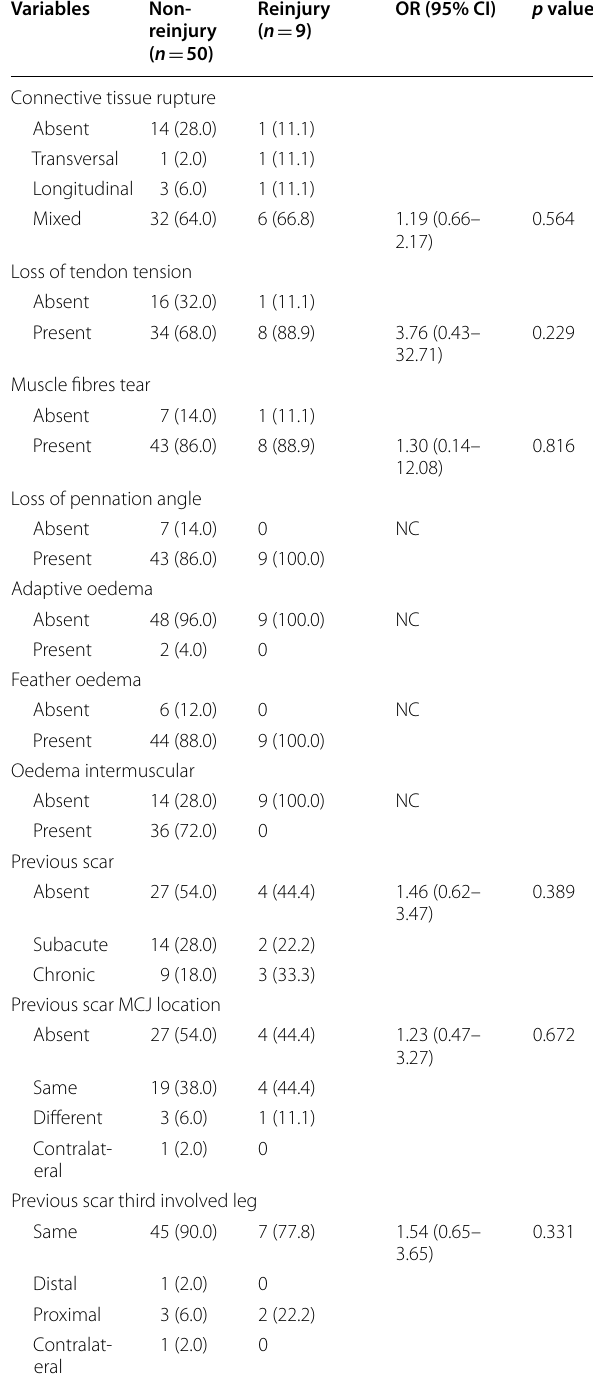
Table 3 Differences in baseline MRI findings between